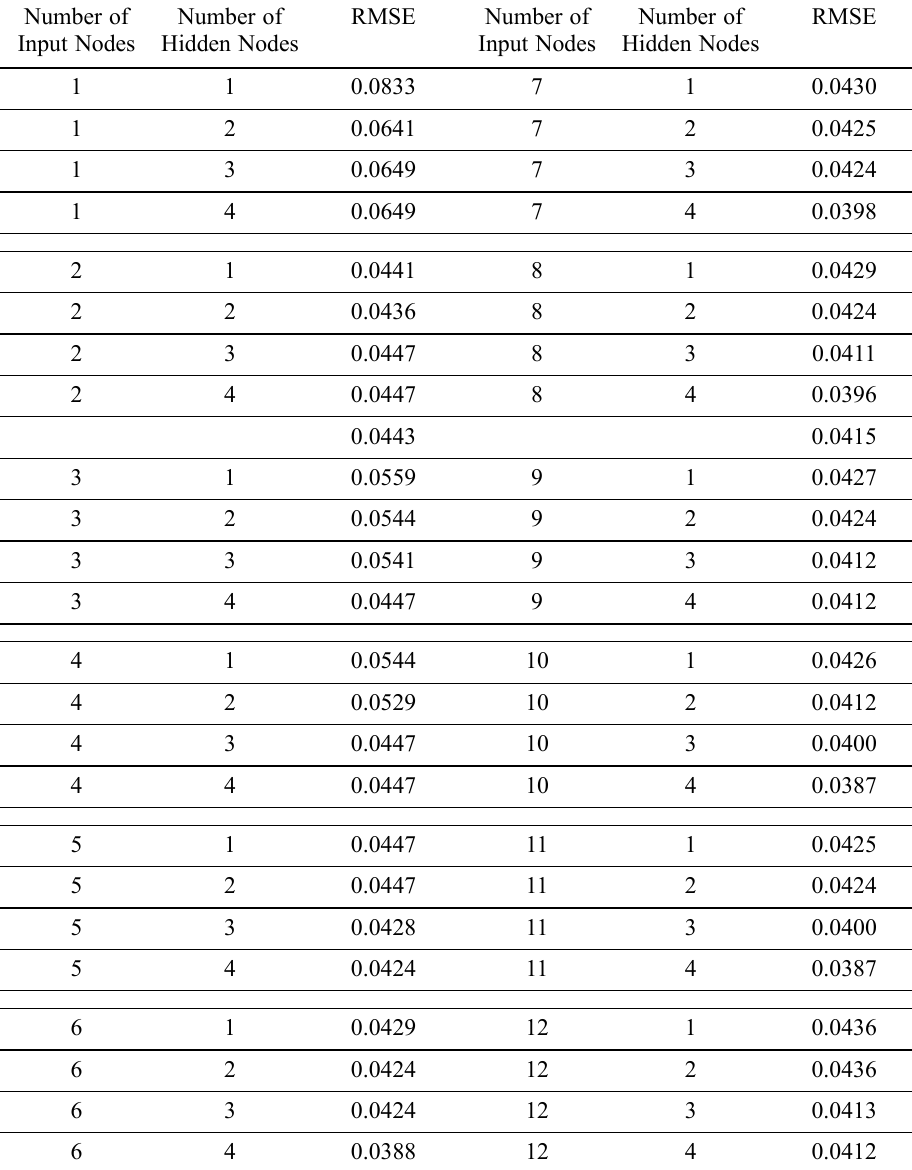
Table 1. Training performance of the alternative ANN